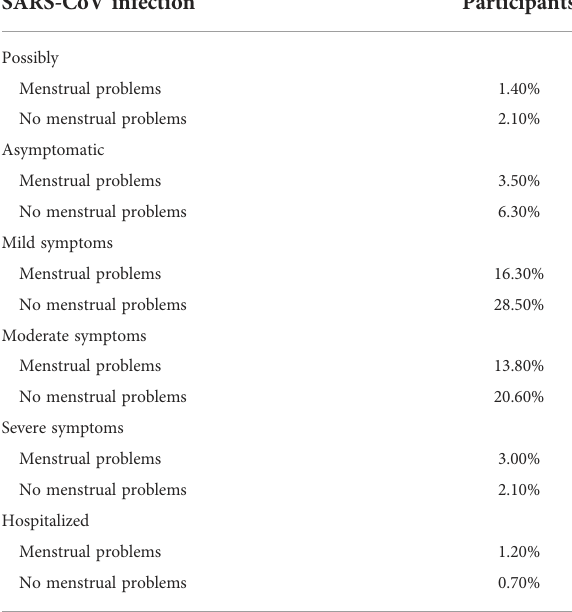
Table 1 summarizes the percentage of female participants with and without menstrual problems with SARS-CoV-2 infection of varying